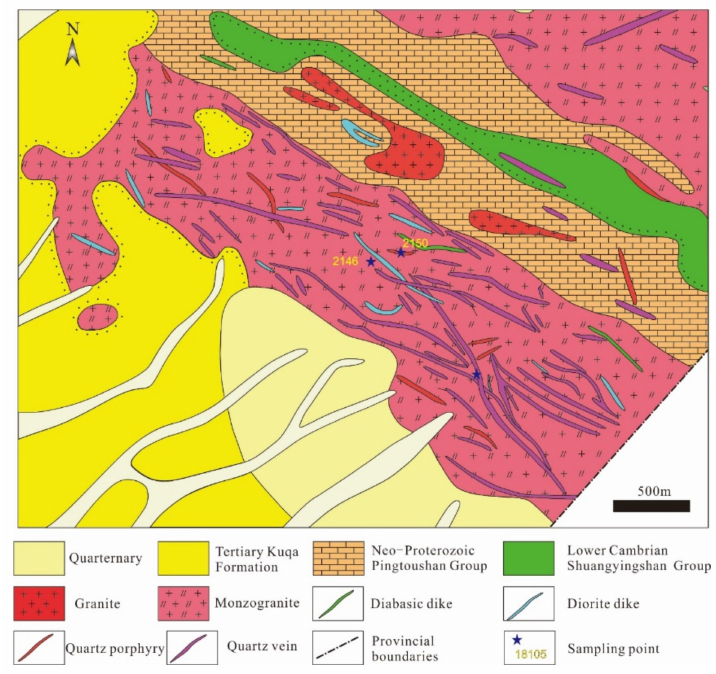
Figure 2. General geologic map of the Juyuan tungsten ore